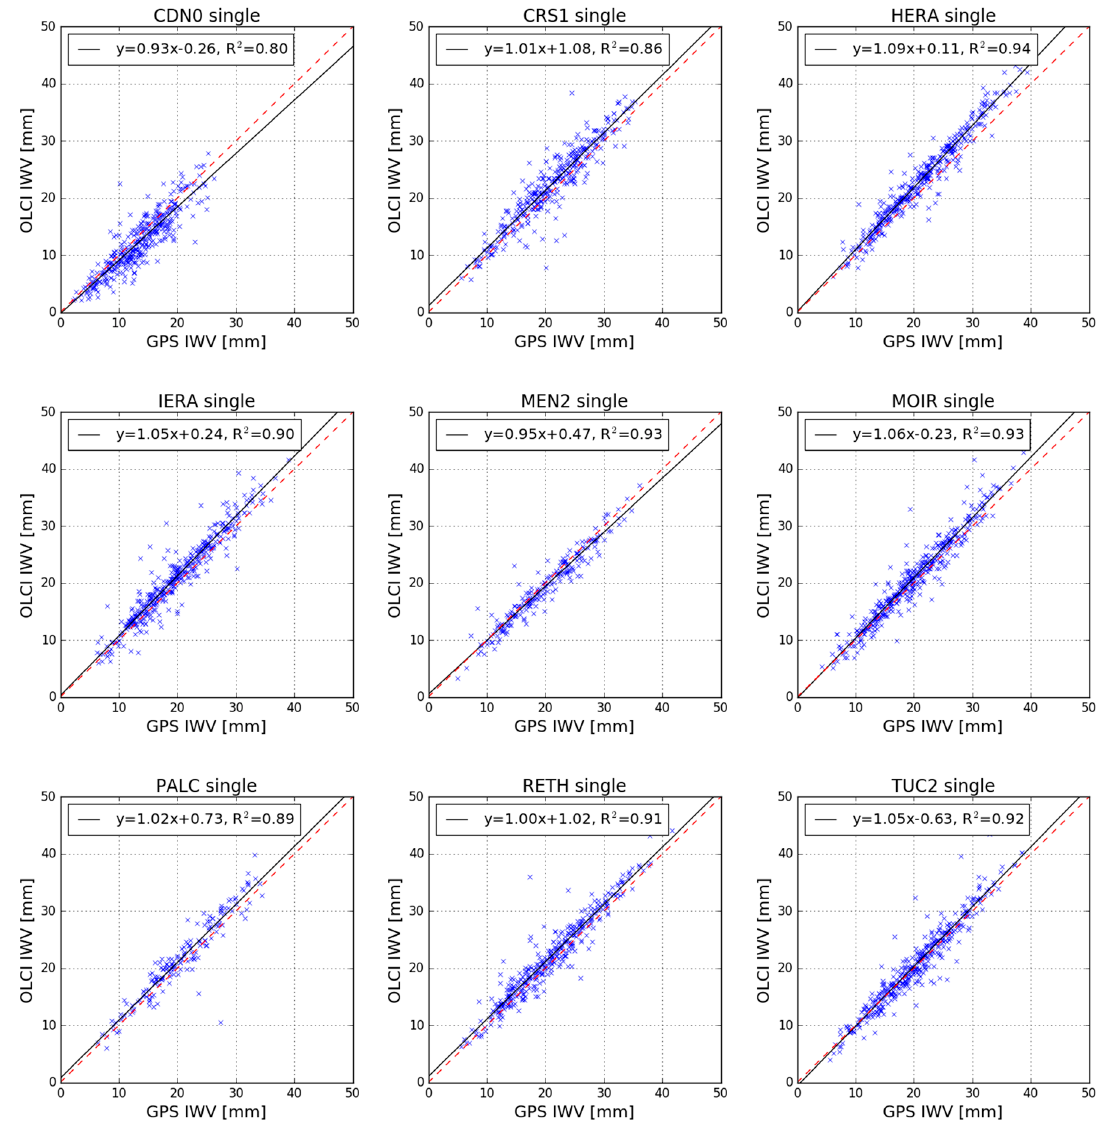
Figure A1. Scatterplots of simultaneous IWV measurements obtained by the Sentinel-3A OLCI instrument as derived by the “single point” approach and the GNSS station at the respective station location.